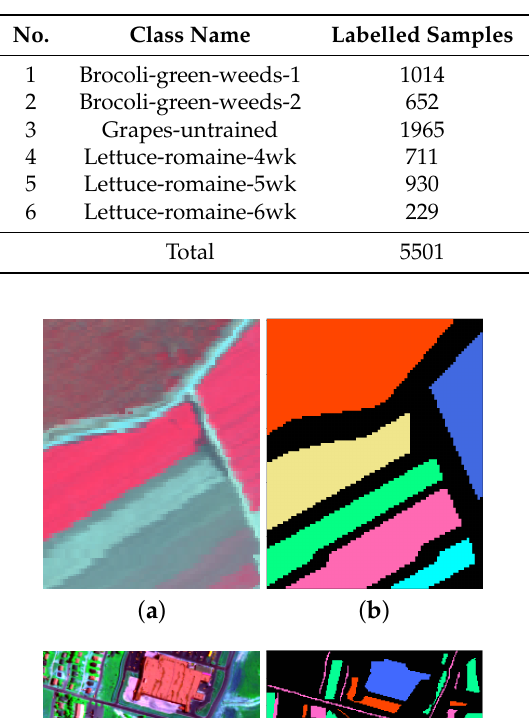
Table 1. Reference classes for the Salinas Scene .